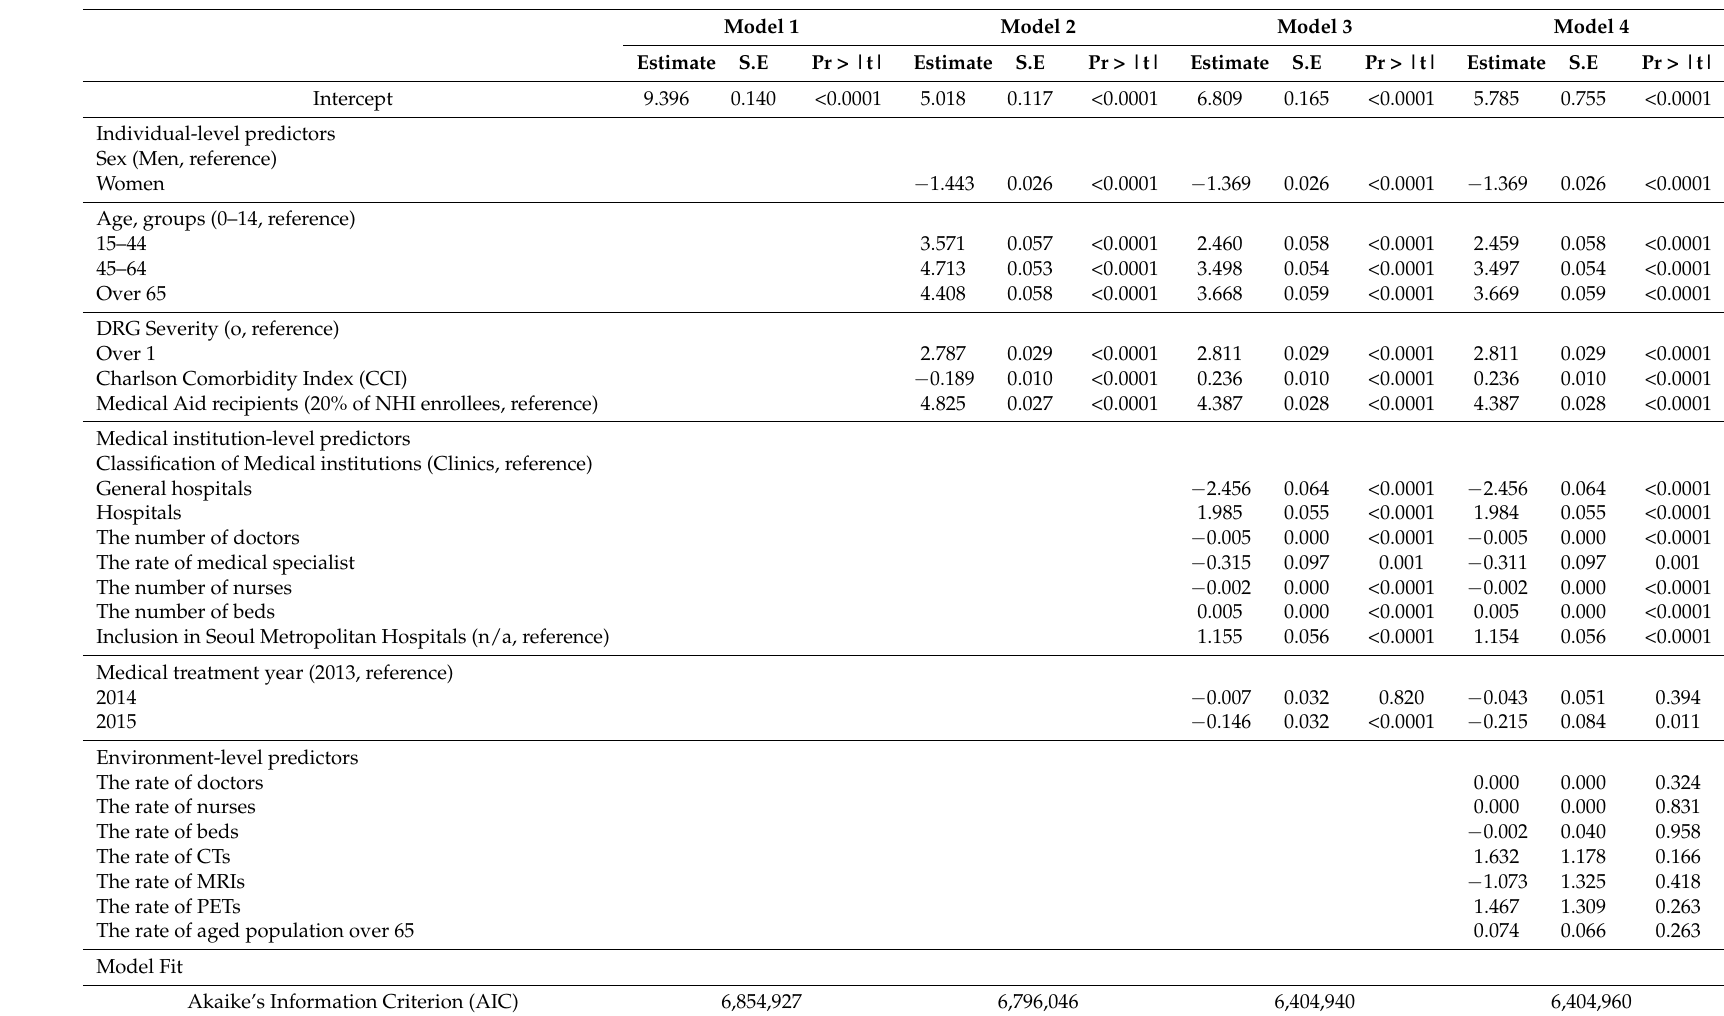
Table 2. Multilevel analysis results—length of